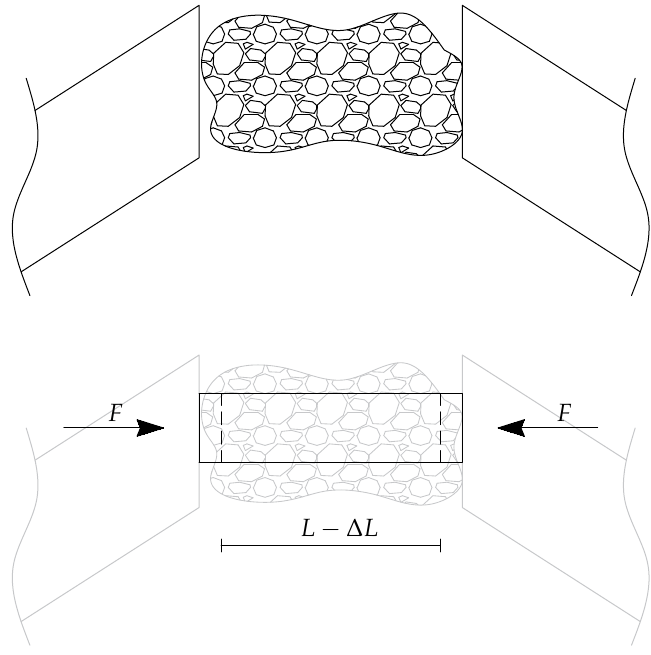
Figure 3. Modeling of tissue